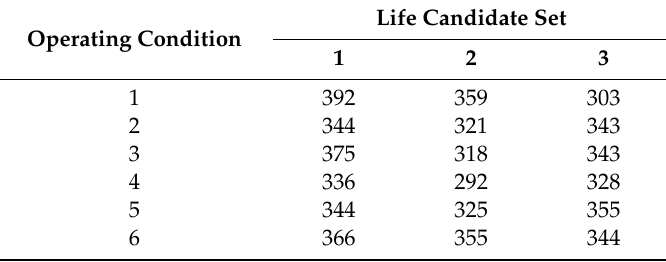
Table 4. The life candidate set of each operating condition.